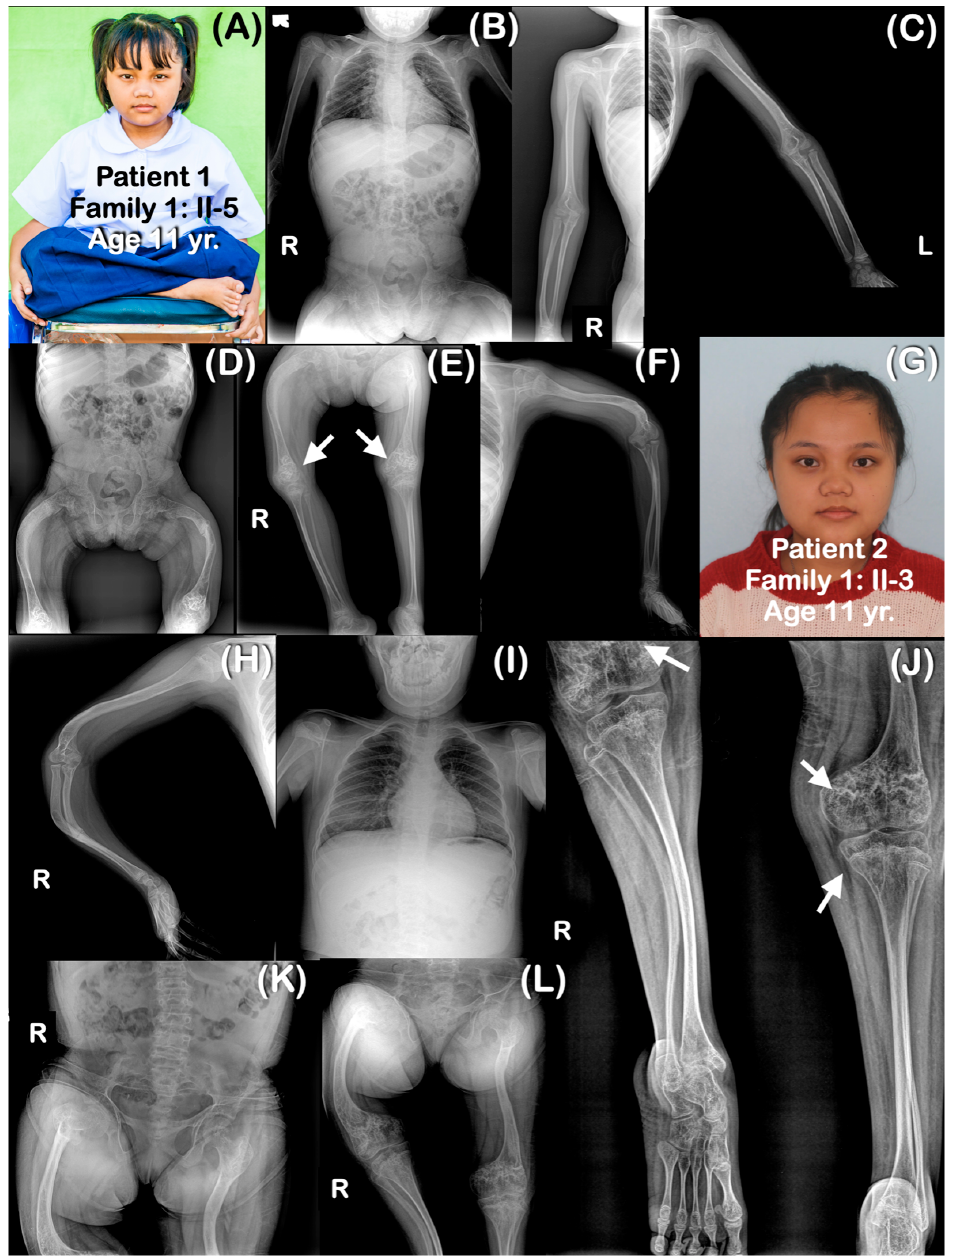
Figure 2. Family 1. ( A – F ) Patient 1 (Family 1: II-3). Age 11 years. Generalized osteopenia is noted. Ribbon rib deformity is observed. ( E ) Popcorn calcifications are observed at distal femoral metaphyses (arrows). Femora are shortened and curved. Fracture of left femur is healed. Humeri, radii, ulnae, tibiae, and fibulae are not bowed. ( G – L ) Patient 2 (Family 1: II-5). ( G ) Sister of patient 1. Age 17 years. Radiographs taken at 10 years. Generalized osteopenia is noted. Curved and slender long bones. The right femur is shorter than the left one. ( L ) Popcorn calcifications are observed at distal femora (arrows).